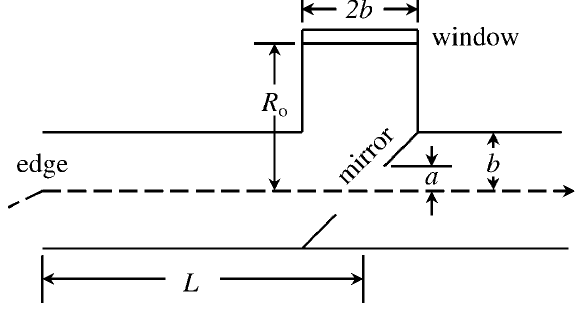
FIG. 2. Radiation distribution at the extraction window from a mirror with no hole when the window is located 64 mm from the straight section axis. The dashed line shows the 32-mm radius of the window. (a) l (cid:1) 10 m m, (b) l (cid:1) 100 m m, (c) l (cid:1) 1 mm, (d) l (cid:1) 10 mm, and (e) l (cid:1) 100